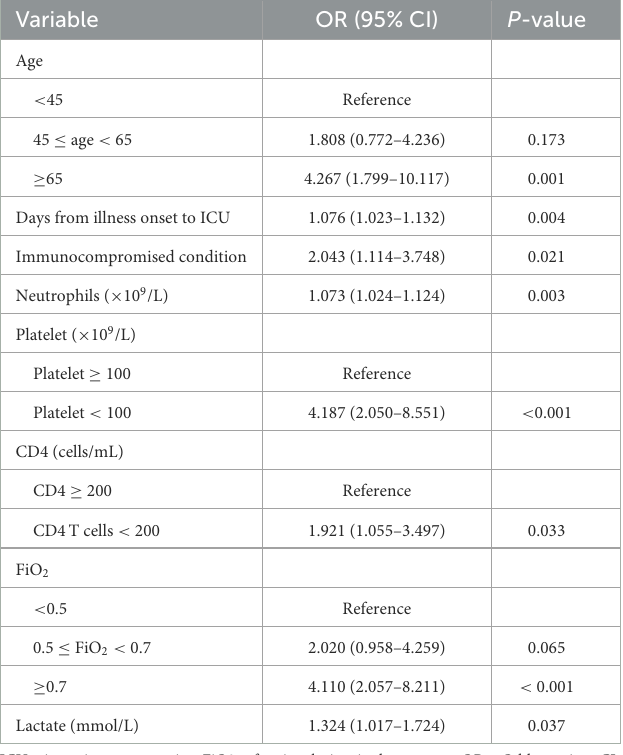
TABLE 5 Risk factors for ICU mortality in all patients with severe community-acquired